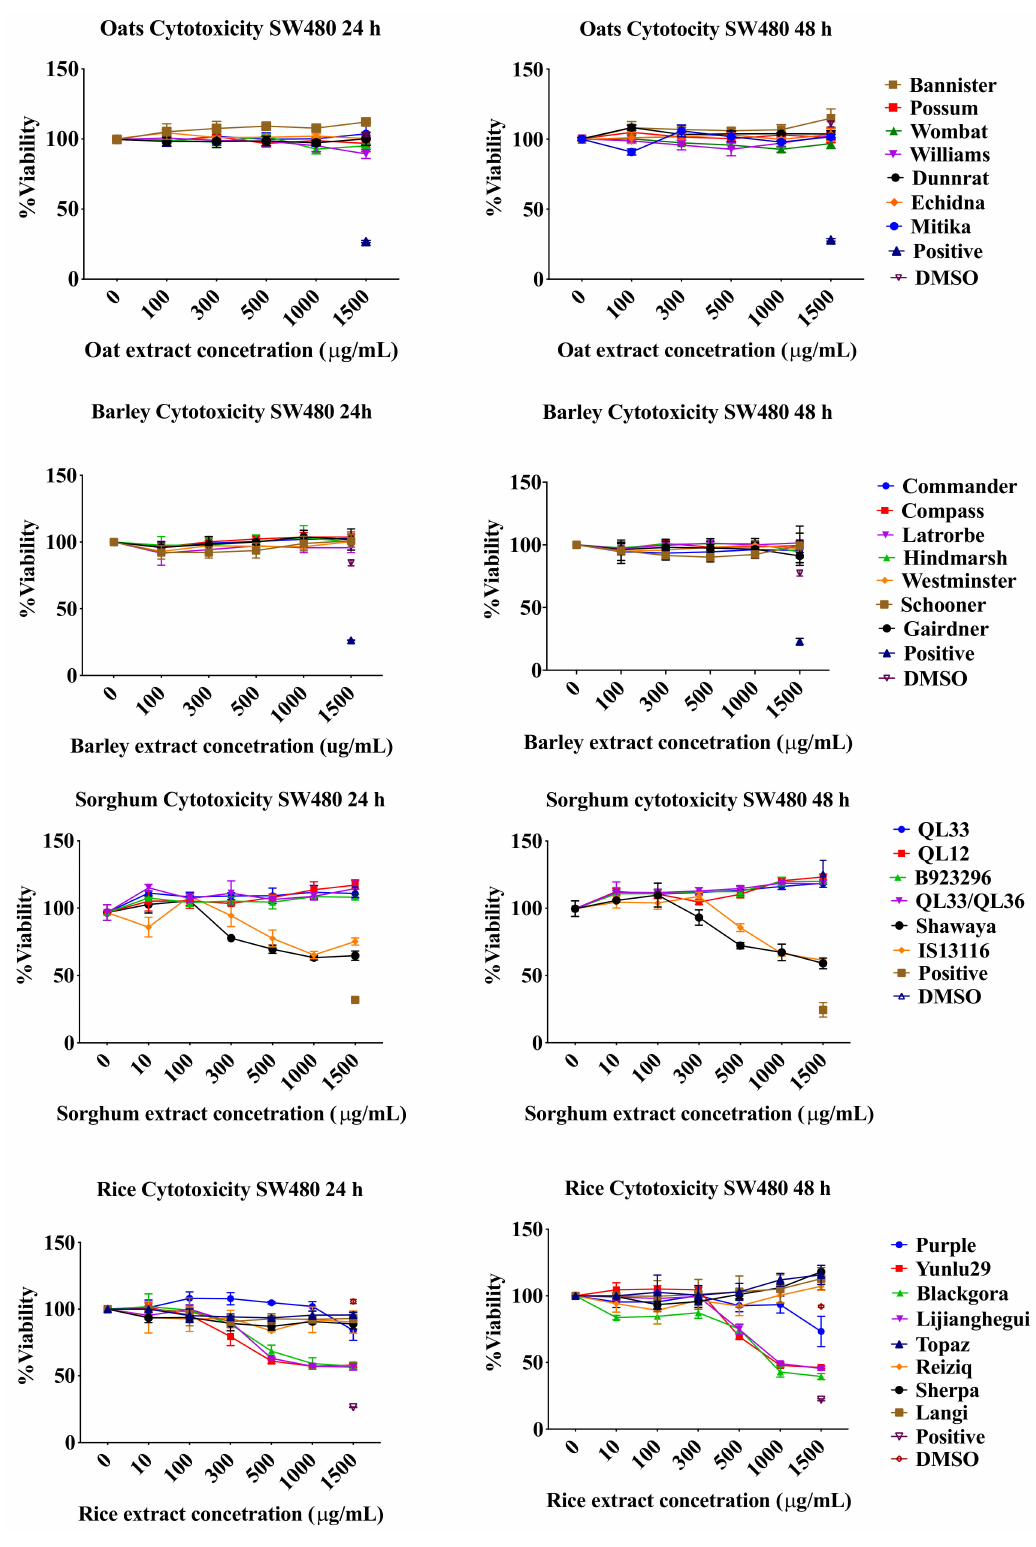
Figure 1. Cytotoxic e ff ects of cereal phenolic extracts on colorectal cancer cell line SW480 at 24 h and 48 h. Results represent mean ± standard deviation (n =